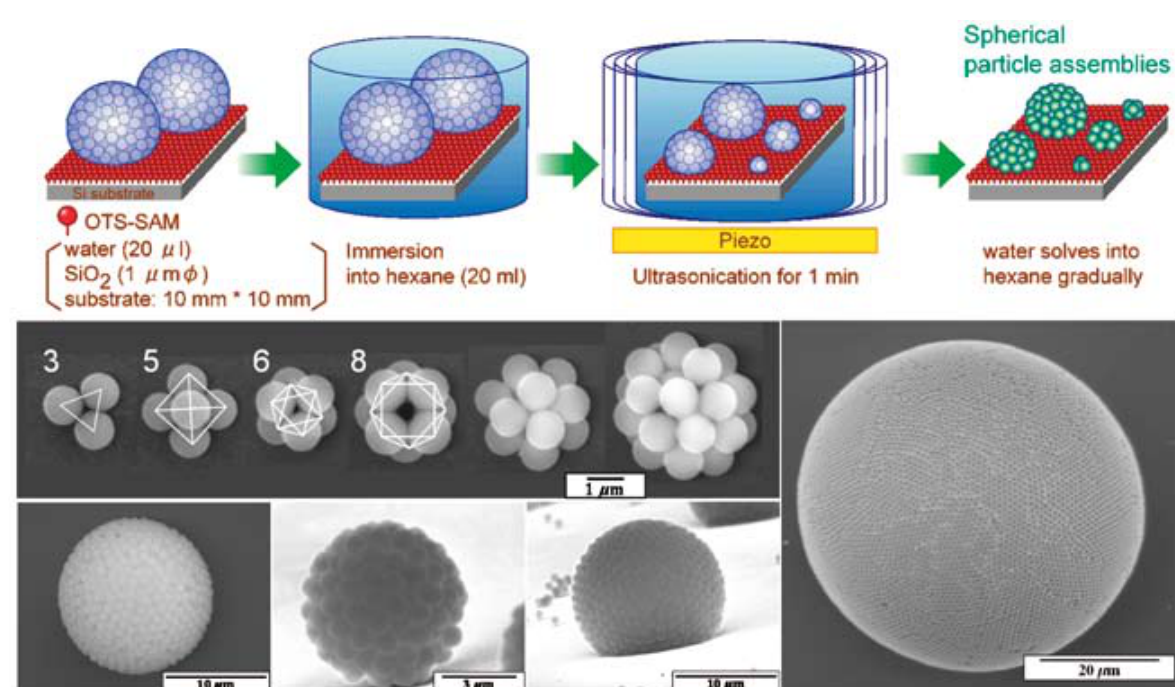
Fig. 1 Conceptual process and SEM micrographs of spherical particle